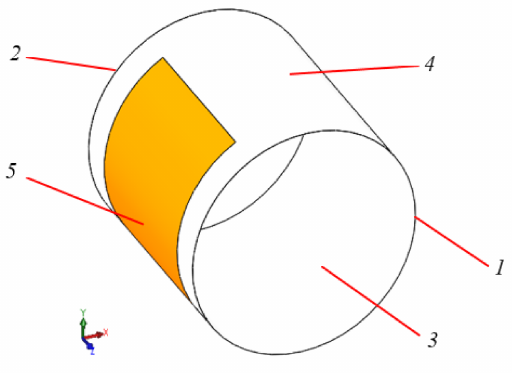
Figure 4. Boundary condition of the computational: (1) pressure and temperature inlet (2) pressure and temperature outlet (3) moving wall (4) no-slip stationary wall (5) slip stationary